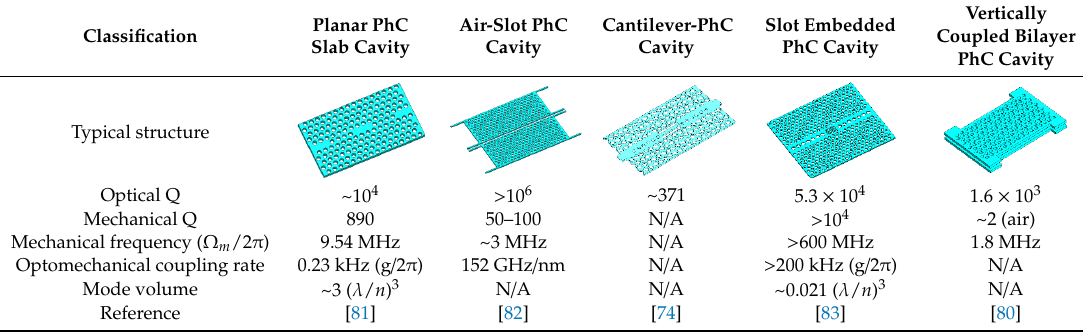
Table 2. Typical configurations of 2D PhC cavities for opto-mechanical interactions.